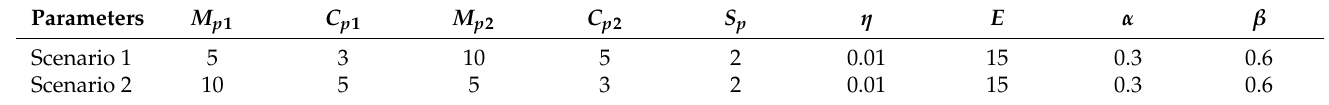
Table 12. The simulation parameters between local government and the public.